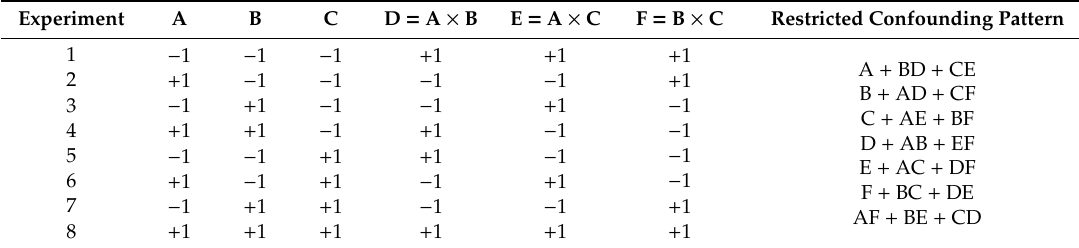
Table 3. The array of